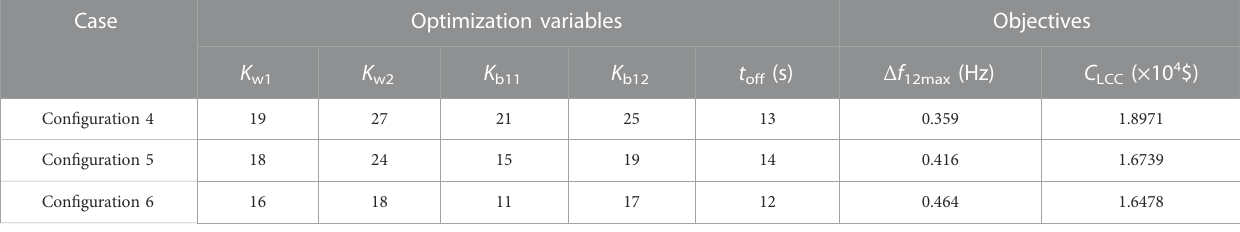
TABLE 3 Optimization results without considering